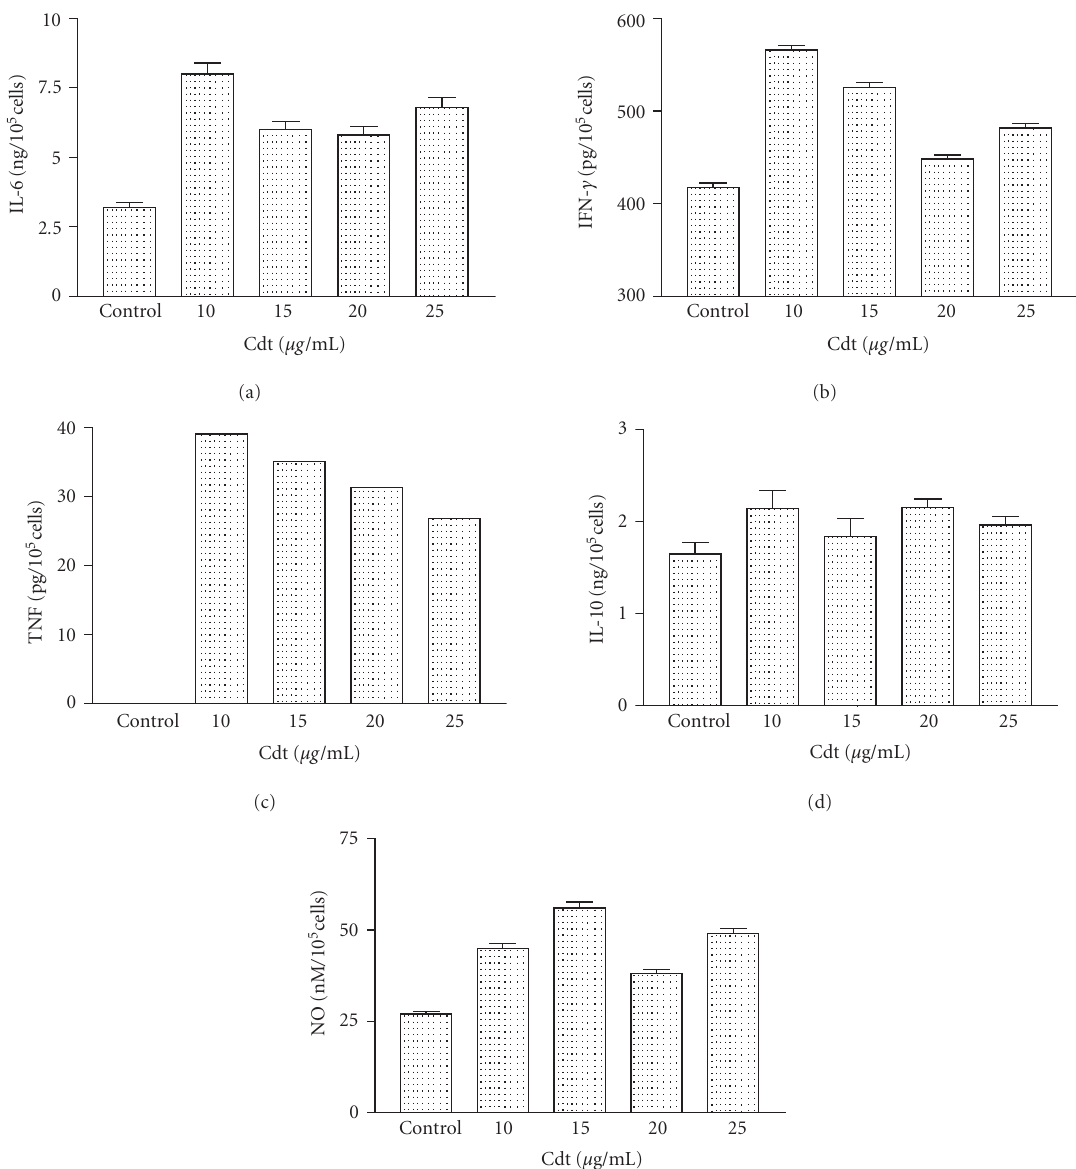
Figure 2. Mediators released by peritoneal macrophages from BALB/c female mice. Peritoneal macrophages were obtained and ex- posed in vitro to di ff erent amounts of Cdt as described in “materials and methods.” The levels of IL-6 were determined after 24 hours, for IL-10 and IFN- γ after 72 hours. They were assayed by ELISA assay using monoclonal antibodies as the probe. TNF levels were determined after 48 hours by standard assay with L929 cells. NO levels were determined after 96 hours by the Griess colorimetric reaction. Each point represents the mean value of samples from five experiments in di ff erent groups of five mice. Statistical di ff erences between the treatments were P > .